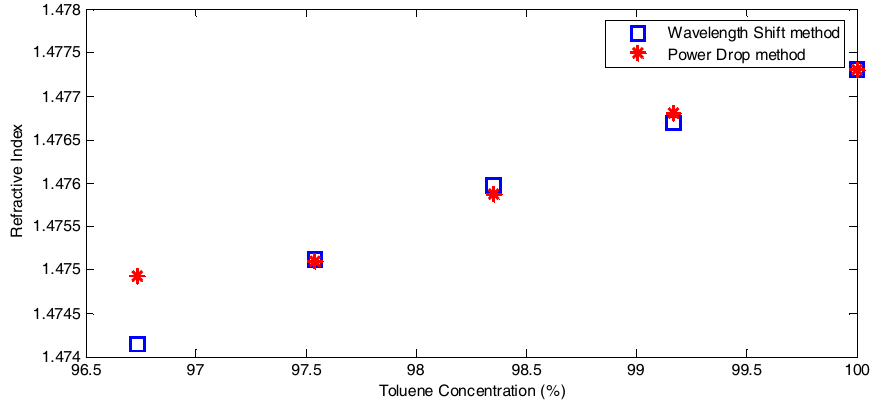
Figure 12. The estimated refractive index versus the toluene concentration in the toluene-acetone mixture.